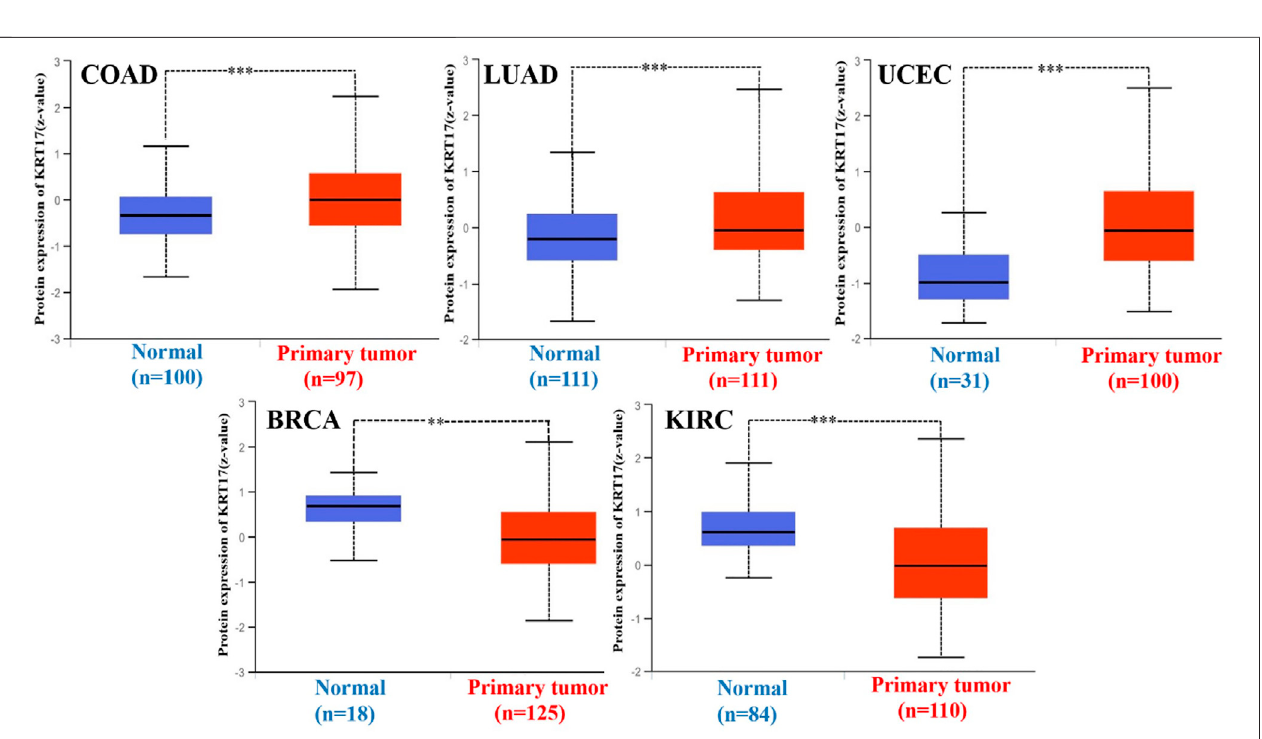
FIGURE 2 | Expression of KRT17 in total protein of COAD, LUAD, UCEC, BRCA, and KIRC. The expression of KRT17 in COAD, LUAD and UCEC tumor tissues washigher than that innormal tissues, while inBRCAand KIRC, the expression ofKRT17 in normal tissues was higher than that intumor tissues ( p p < 0.05; pp p < 0.01; ppp p < 0.001) (CPTAC